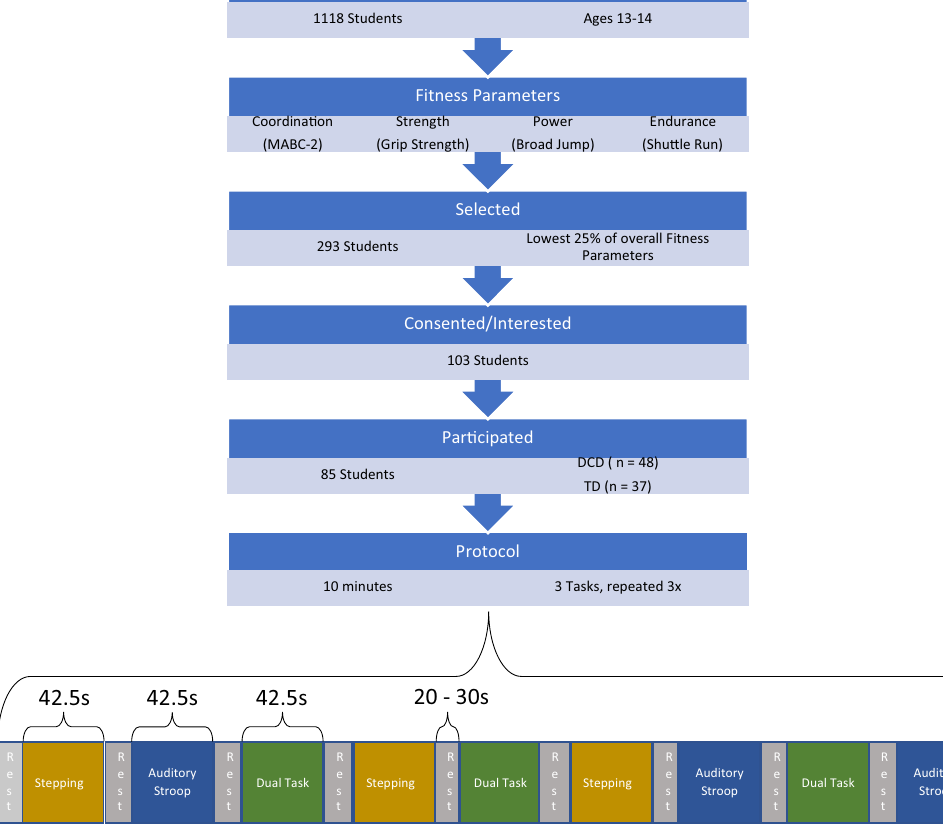
Figure 4. Procedure for participant selection and experimental protocol. Experimental flow, from screening for participants with Developmental Coordination Disorder through running the 10-min protocol. The 10-min indicates the three tasks (Motor Only Task [Stepping], Cognitive Only Task [Auditory Stroop], and the combinatory Dual Task [Auditory Stroop and Stepping simultaneously]) predicated by variable rests of 20–30 s repeated three times each, in a pseudo-random